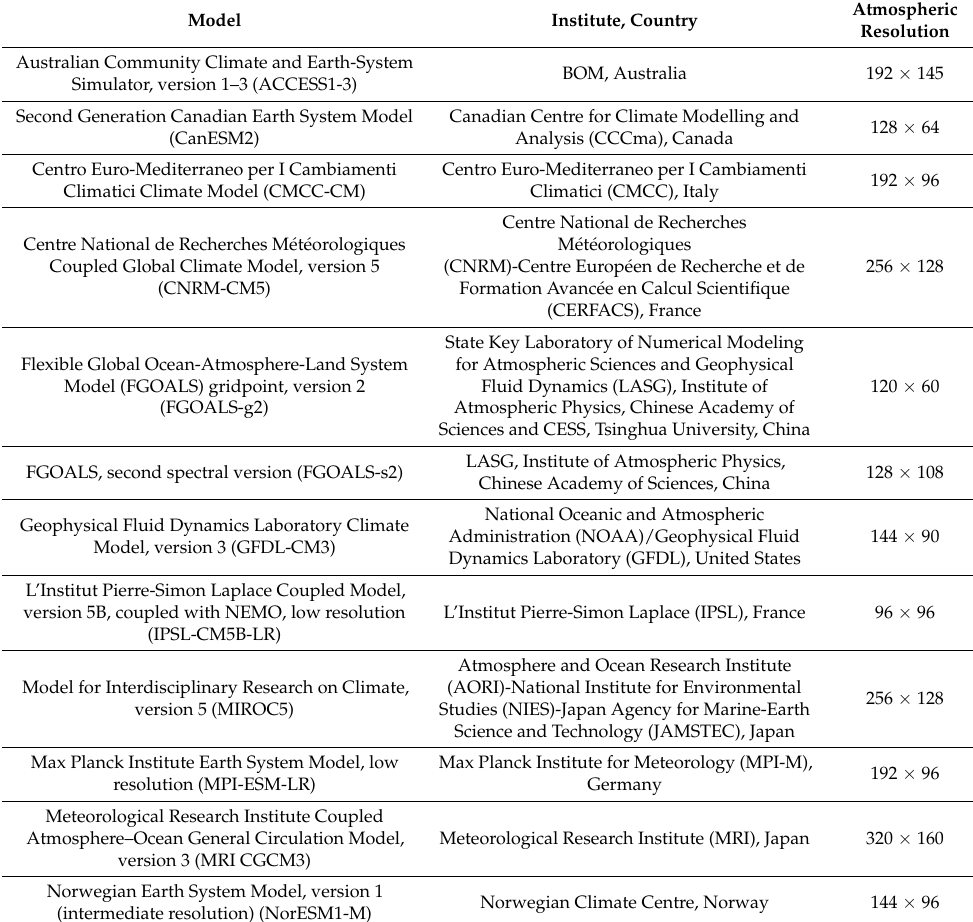
Table 1. List of the Coupled Model Intercomparison Project phase 5 (CMIP5) models used in this study. The atmospheric resolution refers to the number of grid points in each direction ( Lat. × Lon.